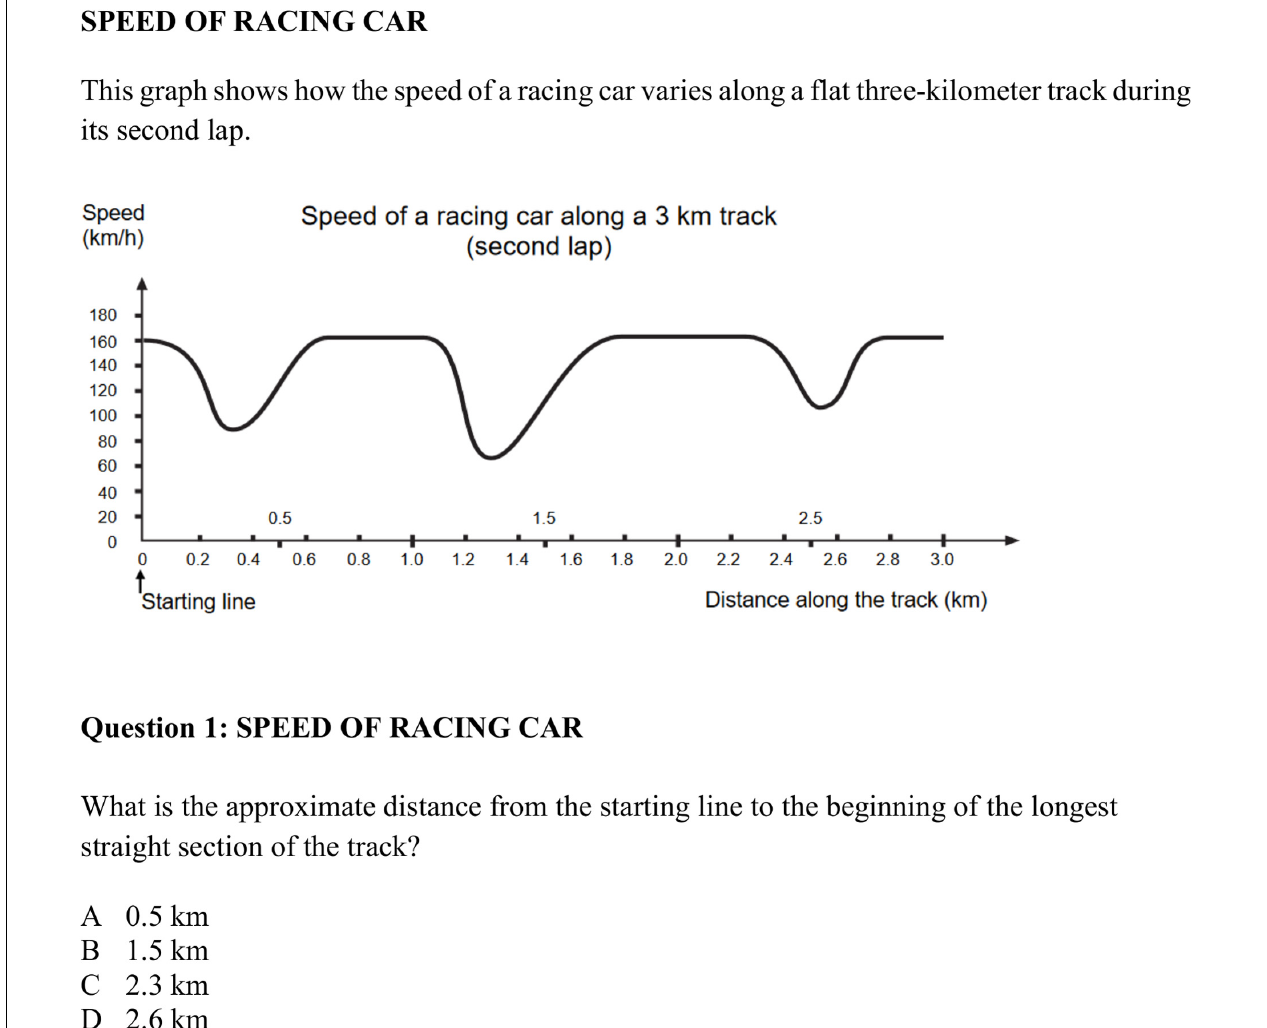
FIGURE 2 | Mathematical task “Speed of Racing Car” [with one out of five questions; subscale “algebra”; from Organisation for Economic Co-operation and Development (OECD), 2003].